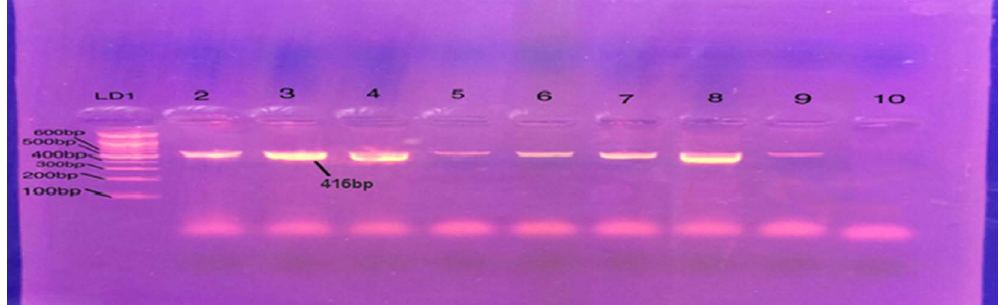
Fig. 1. PCR products amplified with gyr A specific primers in resistant samples before the restriction 416